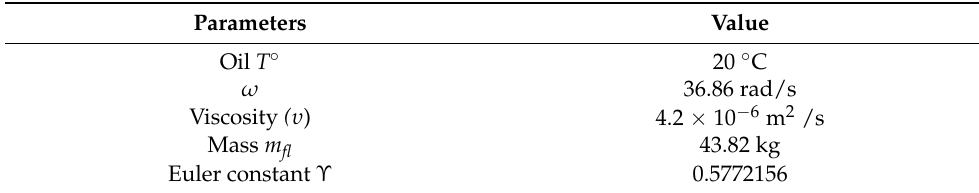
Table 2. Viscous fluid properties. (Oil type GST Oil 32